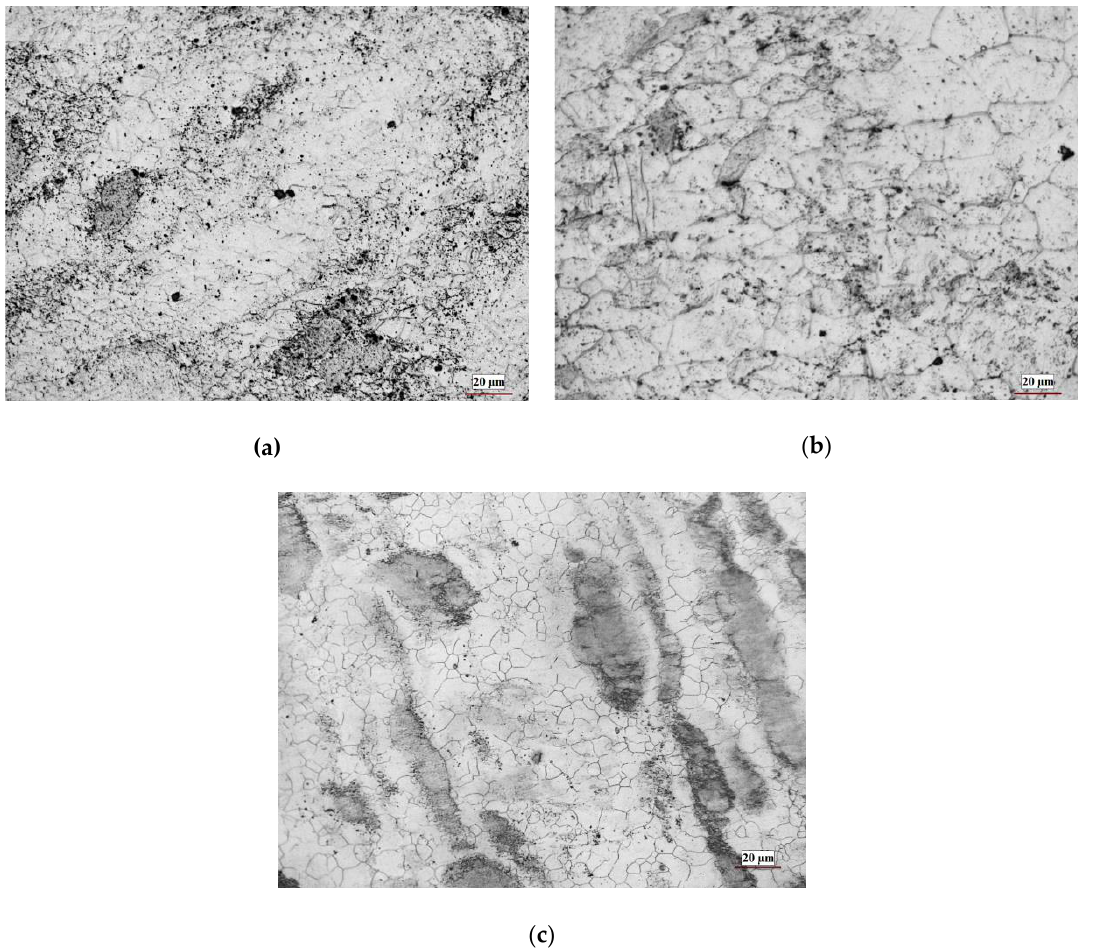
Figure 7. Optical microstructures of the ED specimens deformed at conditions correspond to peak- efficiency conditions of the three domains in the ED processing map (Fig. 4a), which reveals DRX features. The compression axis is vertical. ( a ) 300 °C and 0.0003 s −1 (Domain 1); ( b ) 500 o C and 0.0003 s −1 (Domain 2); ( c ) 400 °C and 10 s −1 (Domain 3).